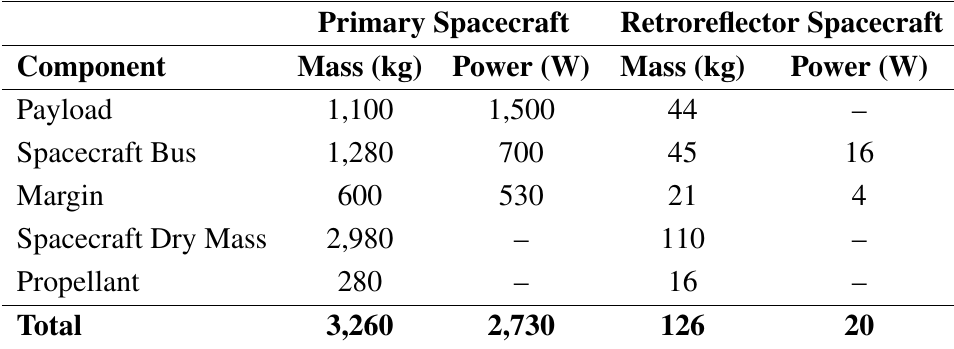
Table 2. Mass and power budgets for the primary and the retroreflector